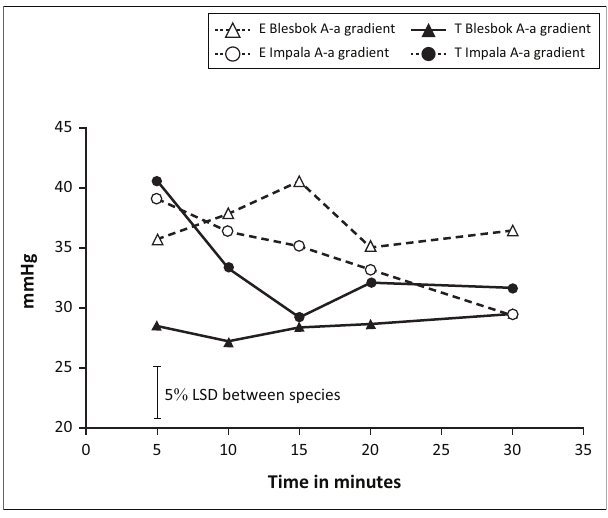
FIGURE 3: A-a gradient in mmHg over time (minutes) of blesbok ( Damaliscus pygargus phillipsi ) and impala ( Aepyceros melampus ) immobilised with 0.09 mg/kg etorphine (E) or thiafentanil (T) respectively. Time was measured from when an animal became recumbent as a result of the immobilisation.